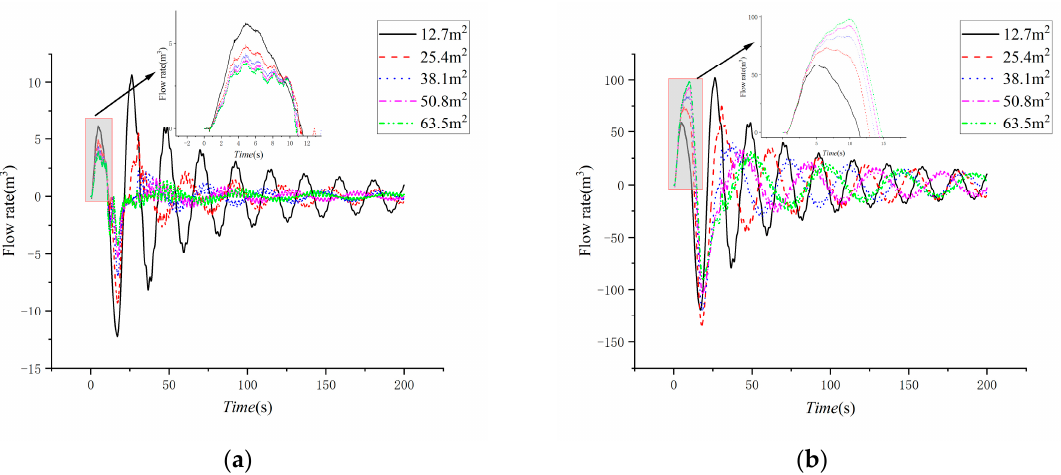
Figure 9. Flow of gate shaft and air hole with different upper chamber areas of gate shaft: ( a ) air hole and ( b ) gate shaft. Table 6. The inflow and rising water level when the water level under different gate shaft areas has reached its highest point.